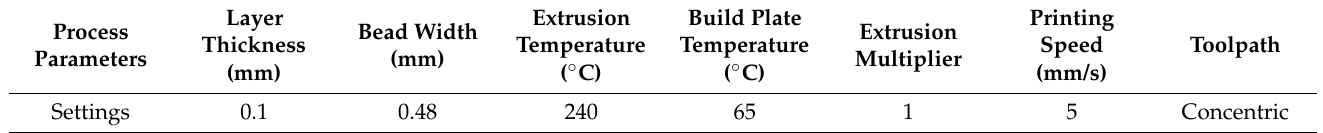
Table 1. Printing process